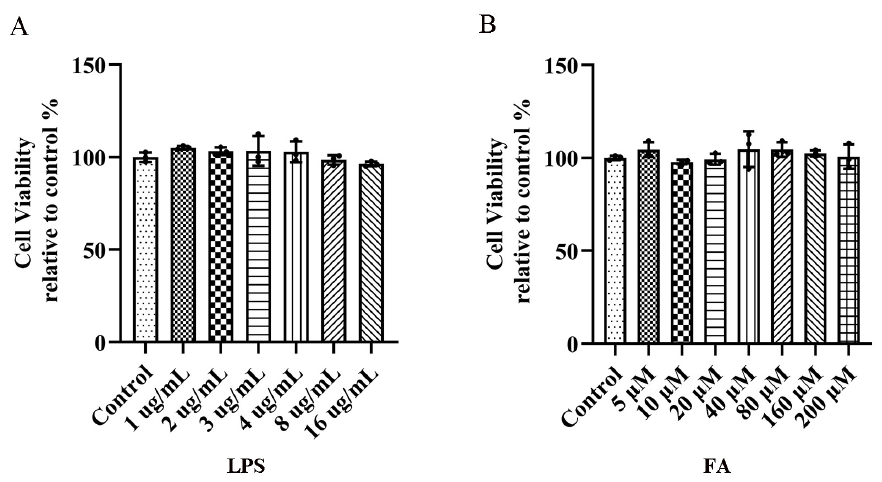
Figure 1. The effects of LPS and FA on BV2 microglial viability. ( A ) Effects of different concentrations Figure 1. The e ff ects of LPS and FA on BV2 microglial viability. ( A ) E ff ects of di ff erent of LPS on cell viability. ( B ) Effects of different concentrations of FA on cell viability. Data are concentrations of LPS on cell viability. ( B ) E ff ects of di ff erent concentrations of FA on cell viability. means ± standard deviations (SDs) ( n = 3). Data are means ± standard deviations (SDs) ( n = 3).